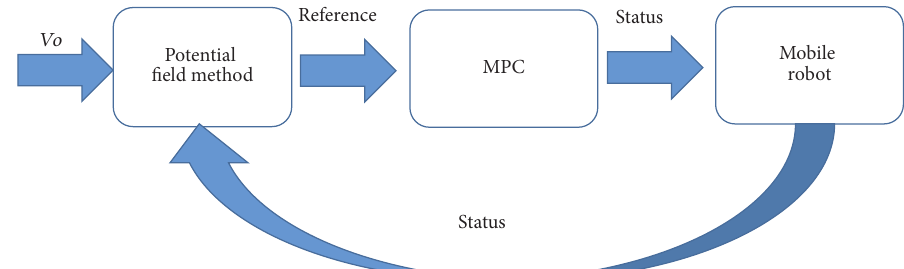
Figure 5: The velocity of the OMR during the simulation.